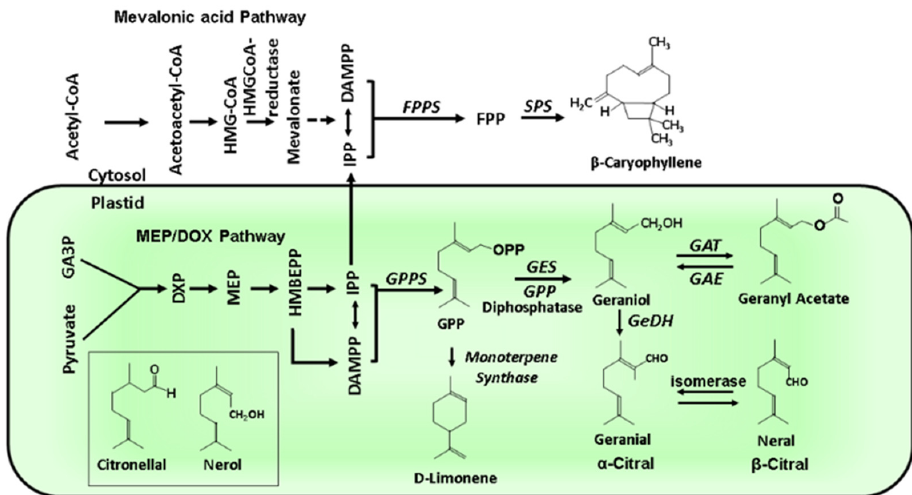
Figure 5. MEP/DOX and mevalonate pathways in plants. The two main biosynthetic routes